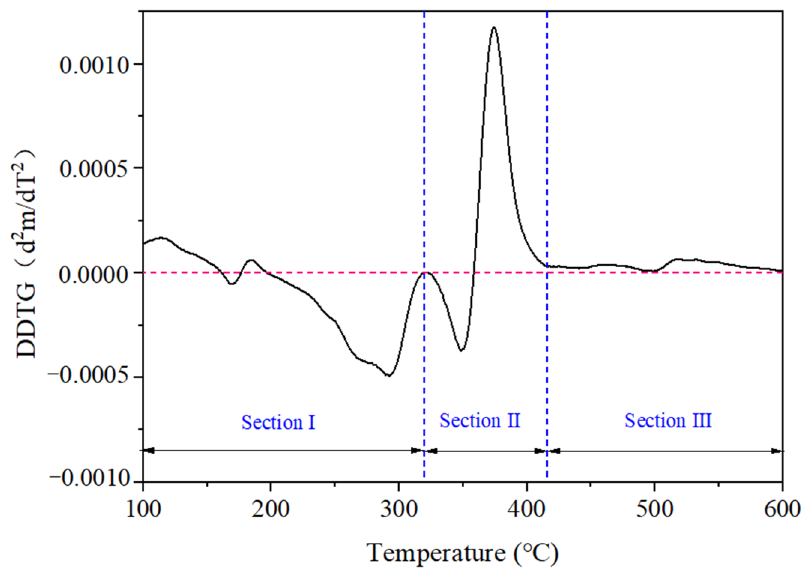
Figure 3. DDTG curve of Stage II using second derivative method. Section I, II and III correspond to the degradation of hemicellulose, cellulose and lignin.